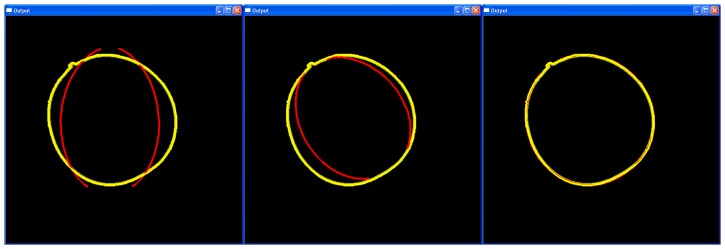
“Output” window showing the visual optimization process of a mistletoe berry's contour.Left: composite picture of a mistletoe berry with the best fitting contour in yellow and the calculated – not yet fitted – path curve in red; center: the path curve being positioned after using the hot-key “M” to define the top and bottom of the path curve; right: the path curve after the optimization using the hot-key “P”.